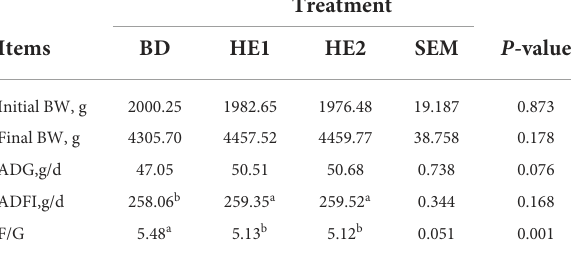
TABLE 2 Effect of HE on growth performance a